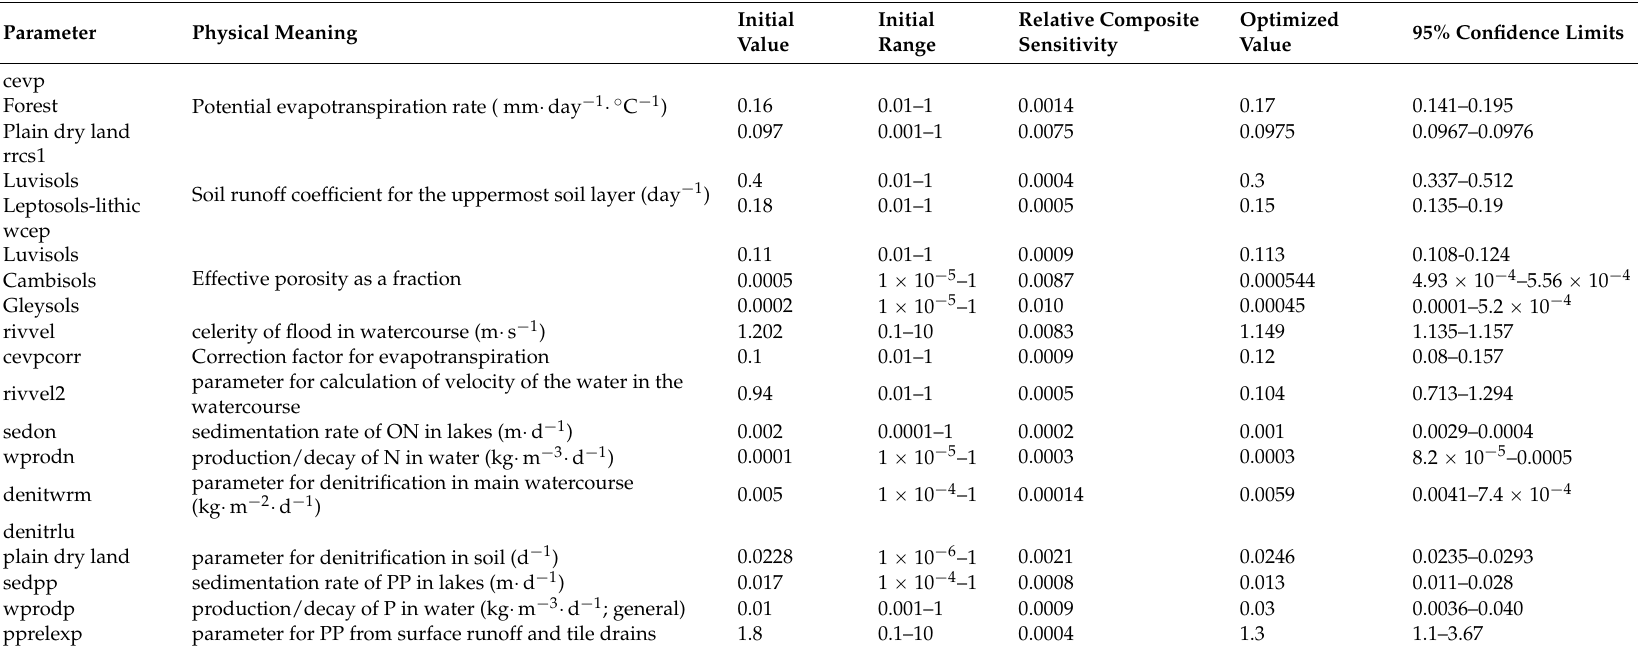
Table 4. Physical meanings, initial values and ranges, parameters’ sensitivity, and optimized values and confidence limits of key